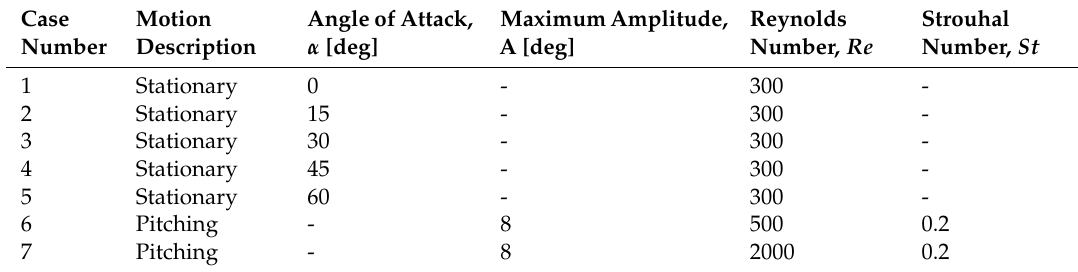
Table 1. Case studies and relevant parameters for each